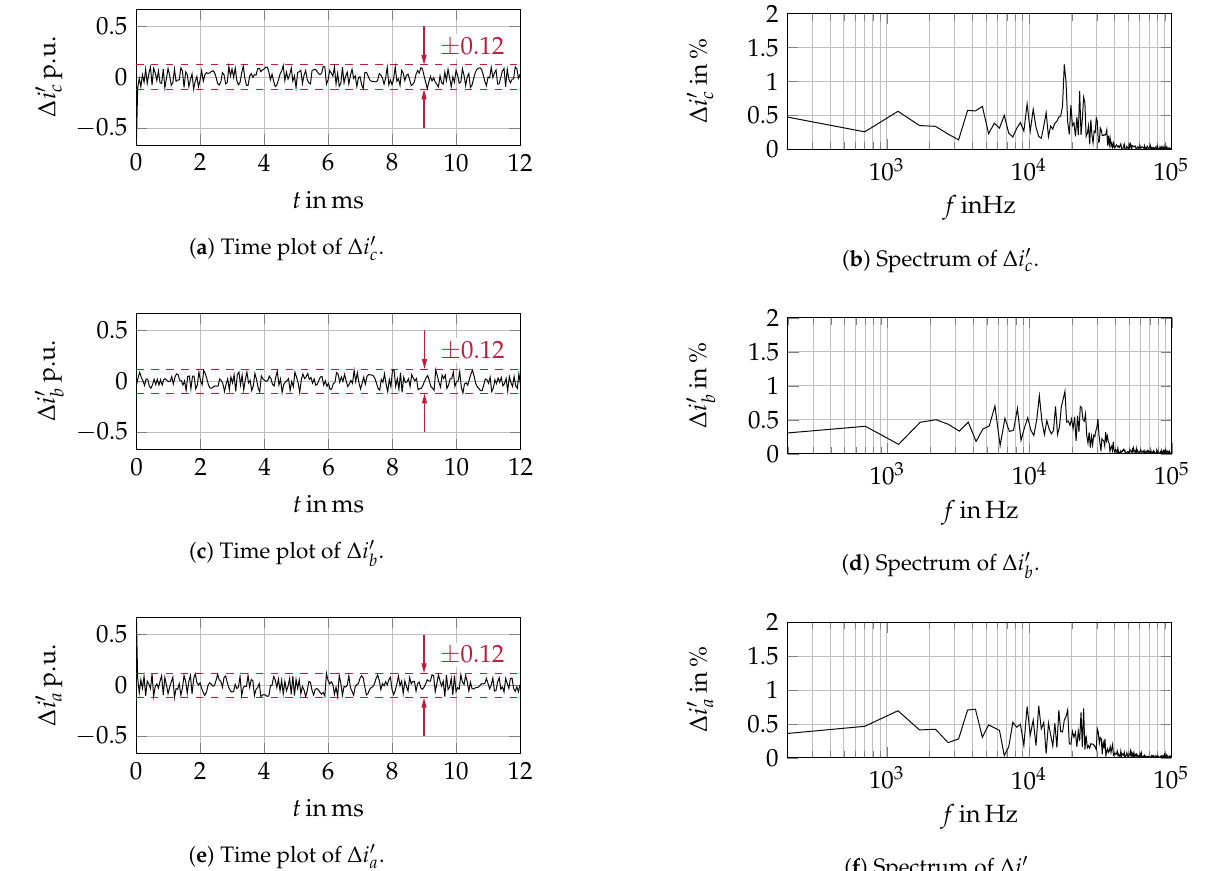
Figure 14. Time plot and spectra of phase current ripple.